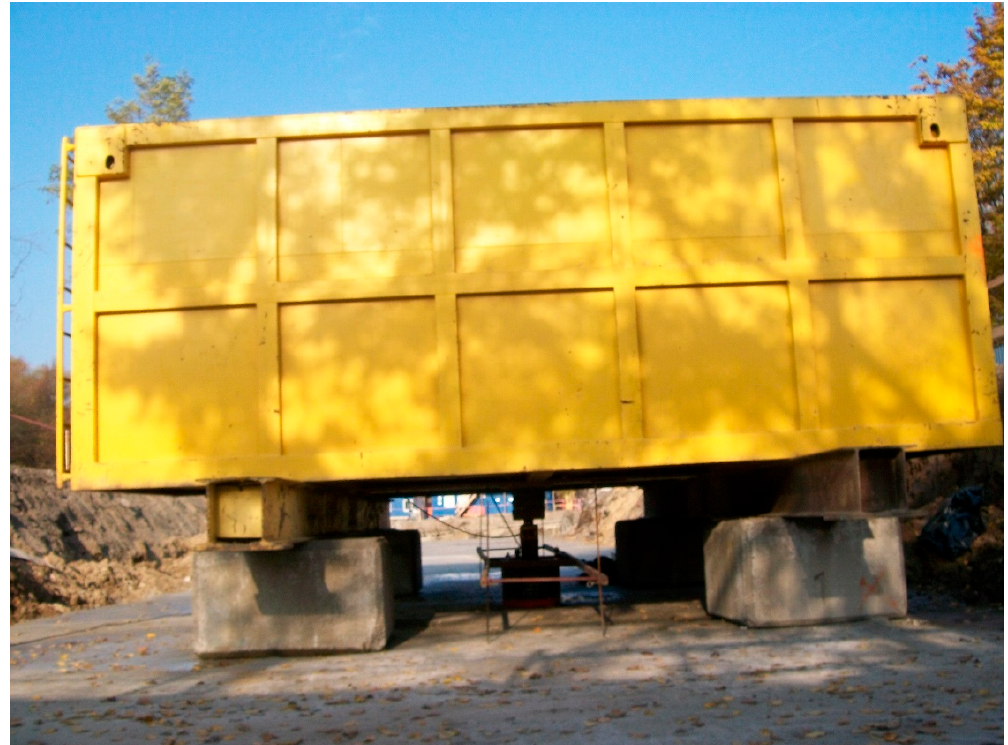
Figure 2. The SLT appliance with kentledge formed by water tanks.